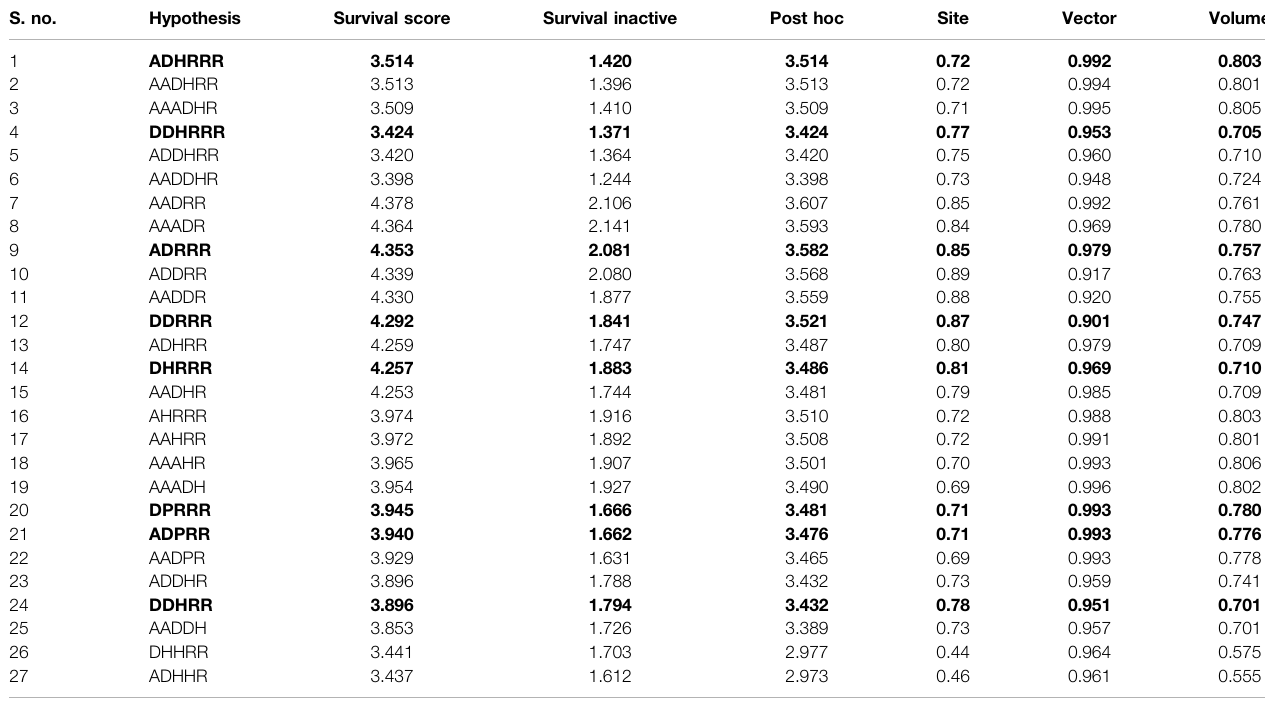
TABLE 2 | The summary of statistical data obtained for the pharmacophore hypotheses. S.